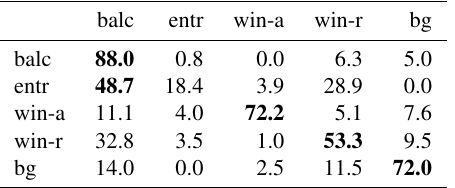
Table 1: Confusion matrix in [%] for learning and testing just using aggregates of A 2 , mean values from five-fold cross valida- tion, accuracy 68 . 5 . Lines: ground truth, rows: prediction, balc: balcony, entr: entrance, win-a: arc-type window, win-r: